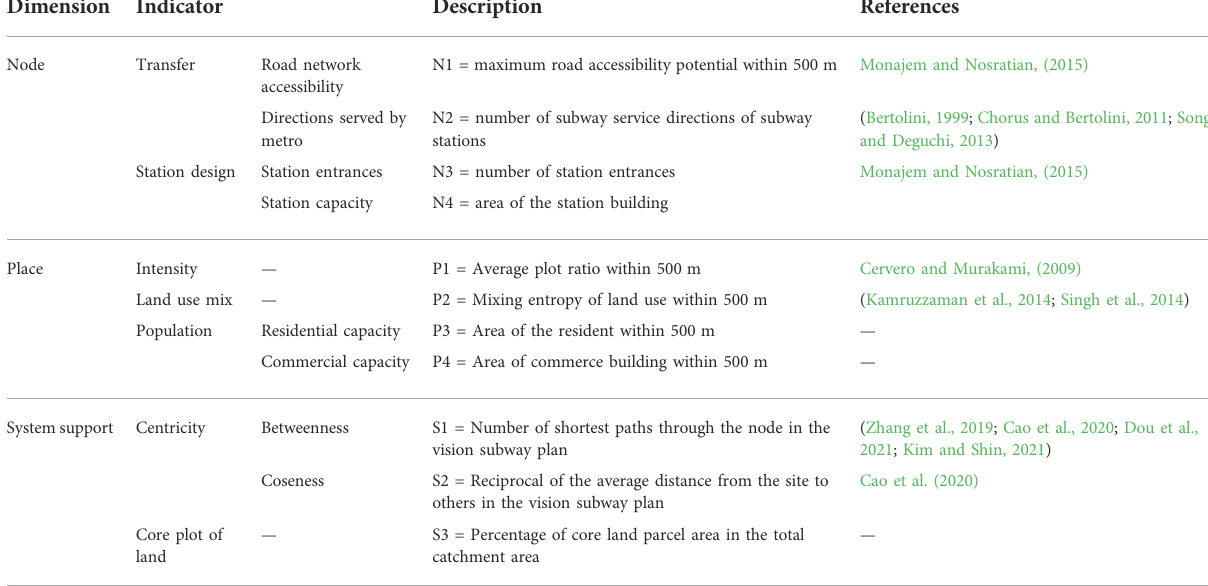
TABLE 1 Indicators of the node, place, and system support